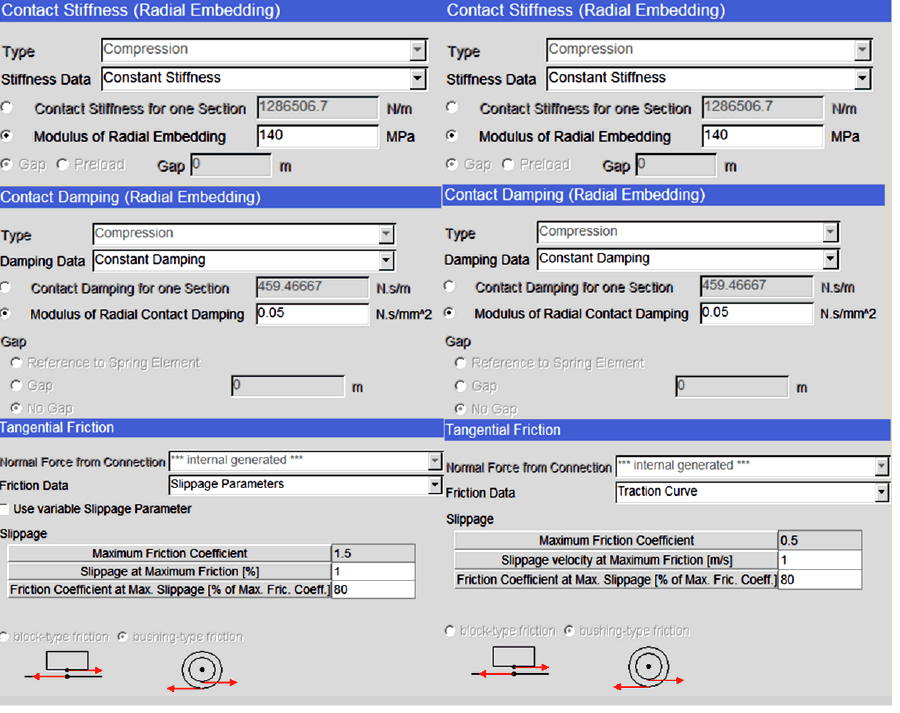
Figure 11. Stiffness, damping, and tangential friction between the belt and the pulley front and back side contacts [10].